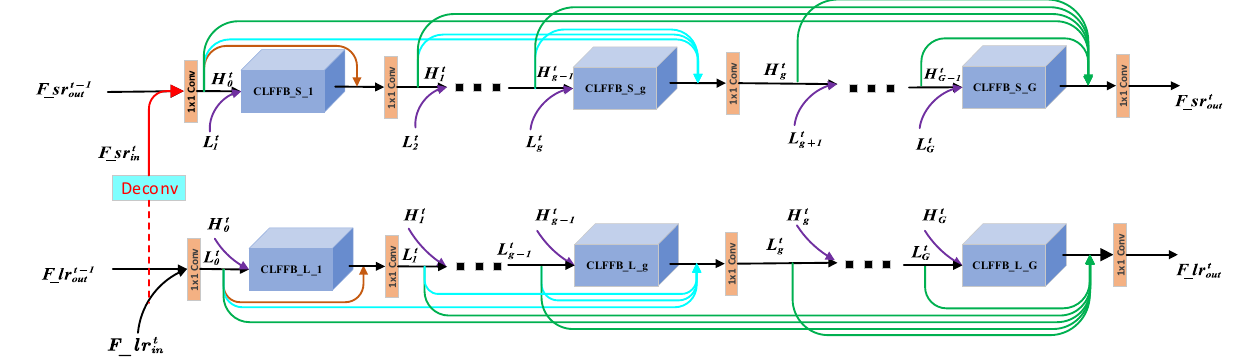
Figure 3. The internal structure of the DLRRB.